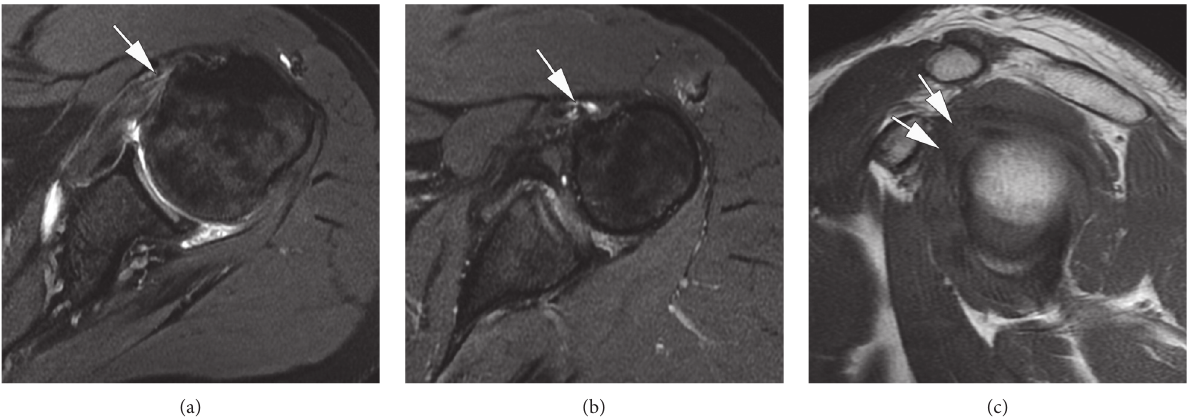
Figure 8: A 32-year-old man with left shoulder pain after dislocation. Axial T2-weighted FS MRI (a) and (b) show an articular surface partial tear of the subscapularis tendon (arrow in a) with tearing and medial dislocation of the long head of the biceps tendon (arrow in b). Sagittal oblique T1-weighted MRI (c) displays loss of normal fat within the rotator interval